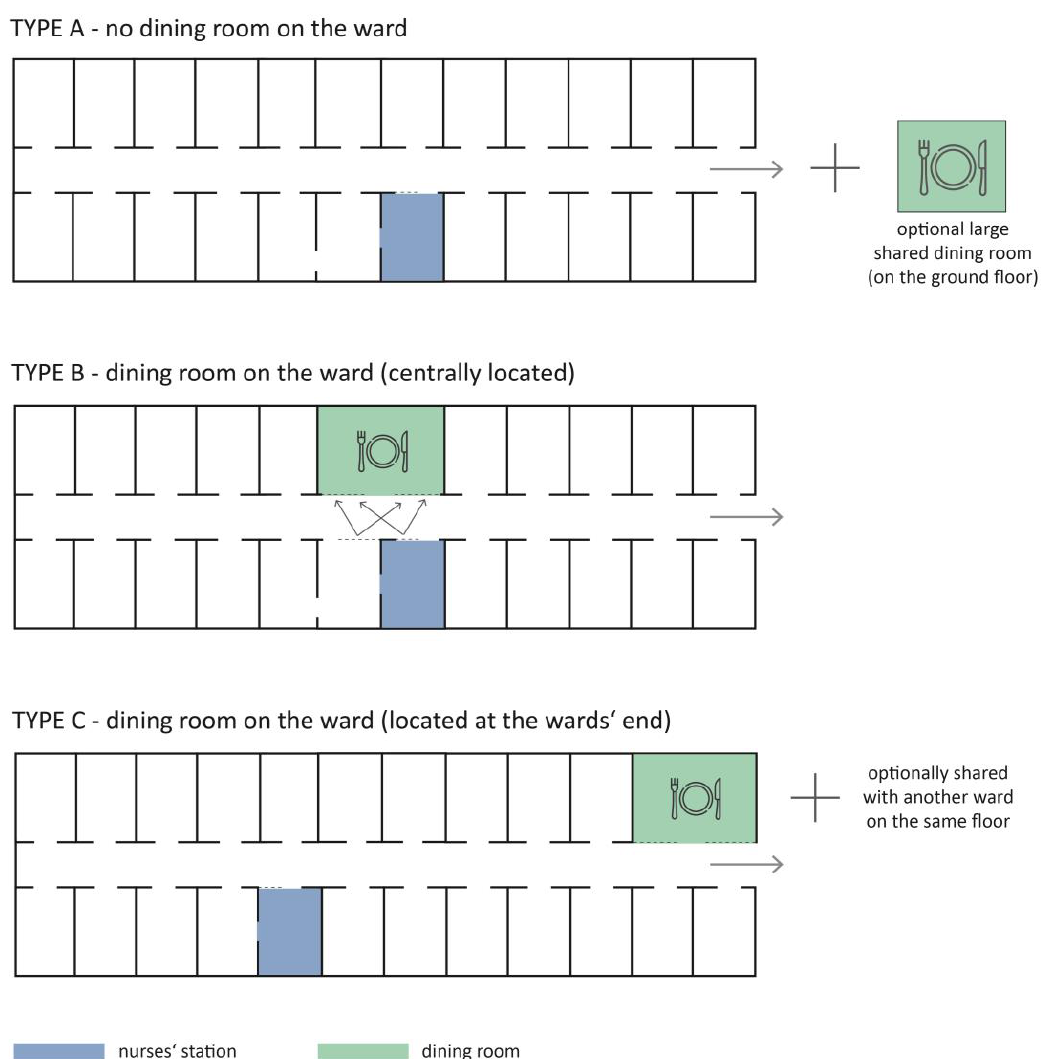
Figure 6. Schematic floorplan representation of the most frequent types of dining rooms in hospi- tals.